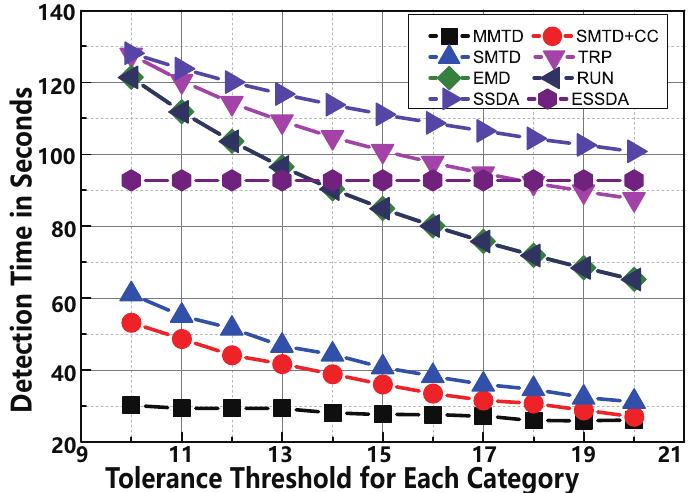
Figure 8. The comparison of time-efficiency between MMTD and other missing tag detection proto- cols when t i is set to be from 10 to 20.